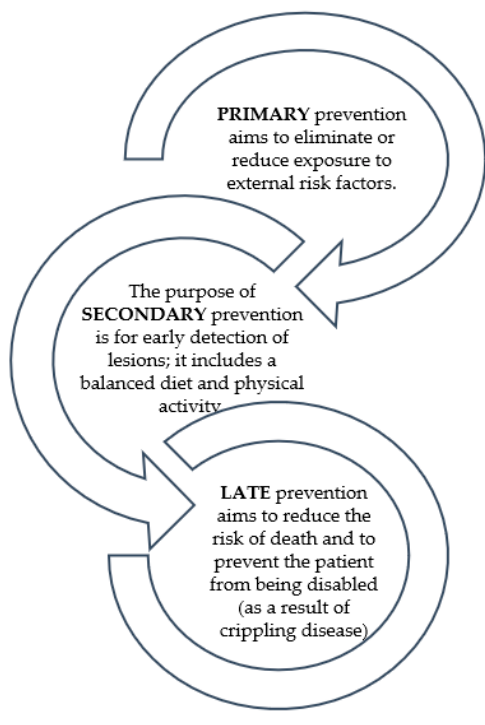
Figure 1. Types of cancer prevention [3,4].